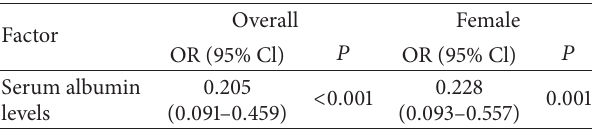
Table 5: A risk factor associated with the development of HCC. Adjusted odds ratios derived from the Cox proportional hazards model. Overall Female Factor OR (95% Cl) 𝑃 OR (95% Cl) 𝑃 Serum albumin 0.205 < 0.001 0.228 0.001 levels (0.091–0.459) (0.093–0.557) OR: odds ratio; Cl: confidence